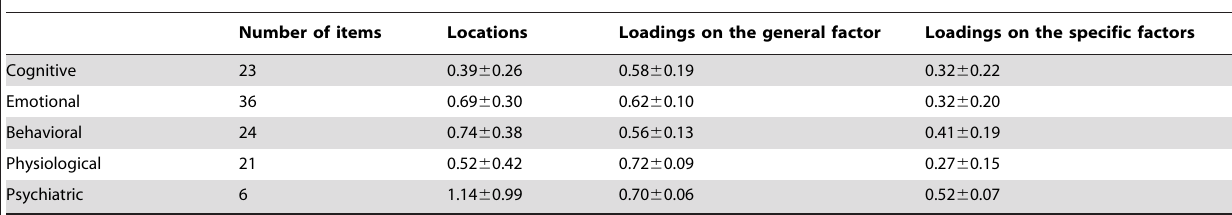
Table 5. Main results of bifactor analysis (M 6 SD).